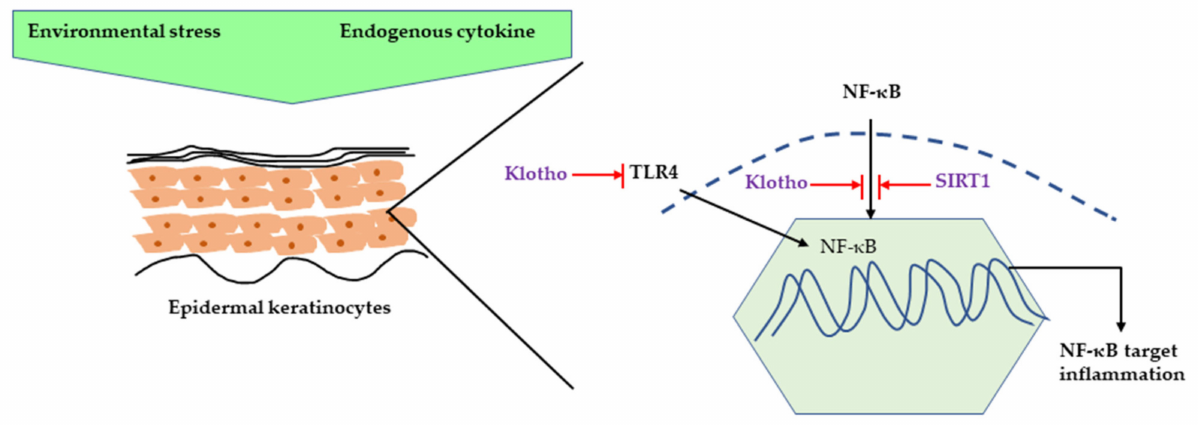
Figure 2. Inhibition of NF- κ B-induced inflammation by klotho and SIRT1. NF- κ B can be activated by different environmental stimuli as well as endogenous cytokines, such as TNF- α and IL-1. Klotho can inhibit the NF- κ B pathway by preventing translocation of NF- κ B or inhibiting TLR4-mediated NF- κ B activation. SIRT1 prevents the NF- κ B pathway by directly inhibiting NF- κ B deacetylating NF- κ B subunit. NF- κ B, nuclear factor kappa light chain enhancer of activated B; TNF- α , Tumor necrosis factor; IL-1, Interleukin 1; TLR4, Toll-like receptor 4, SIRT1, Sirtuin